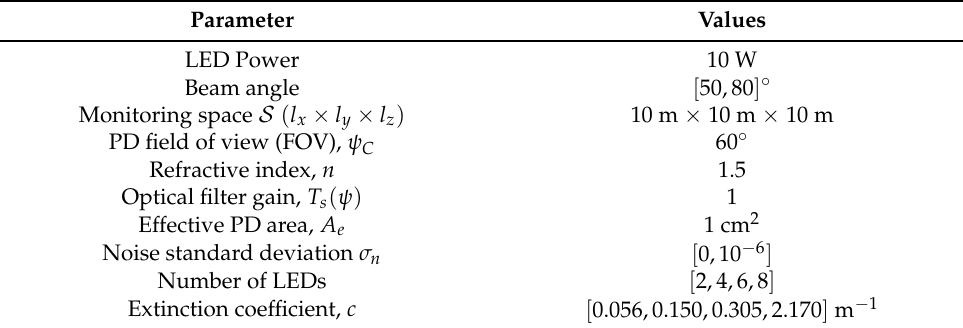
Table 1. Main parameters used in the